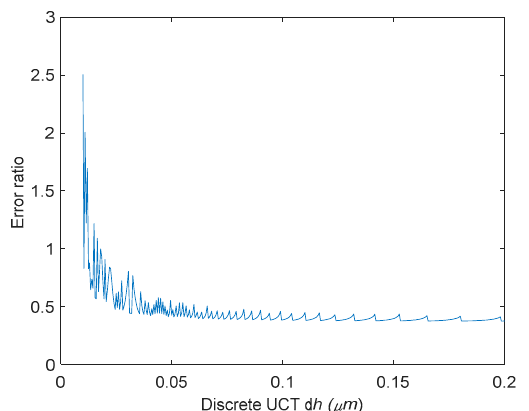
Figure 8. The prediction error vs. the discrete uncut chip thickness (UCT) with the approach of partial rake angle.